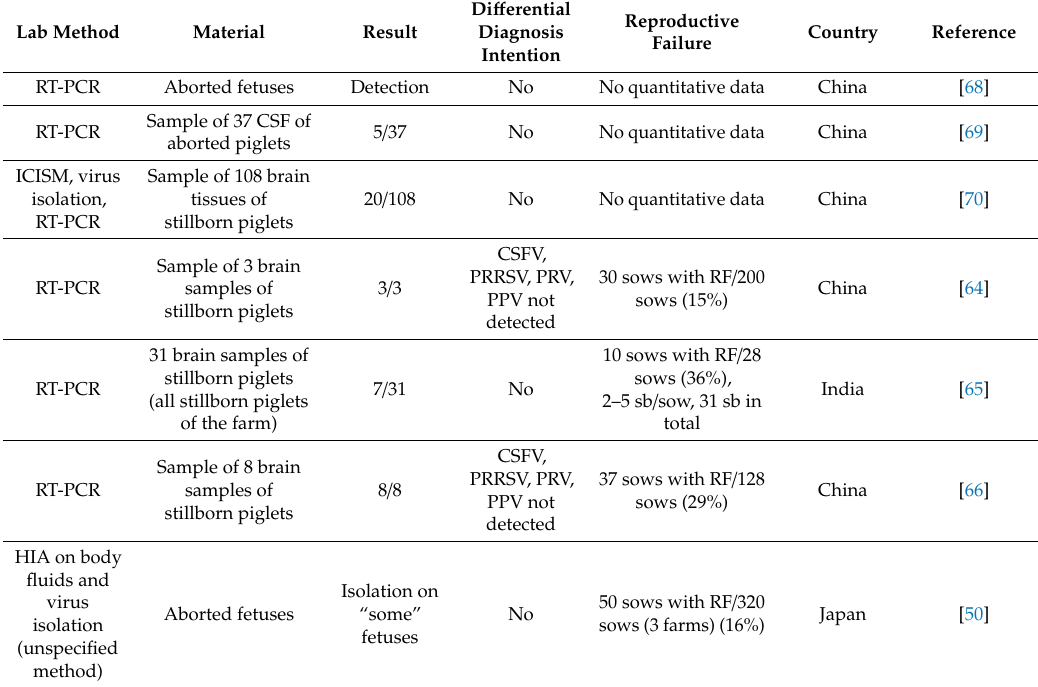
Table 3. Detection of JEV in pig herds with reproductive failure and quantification of reproductive